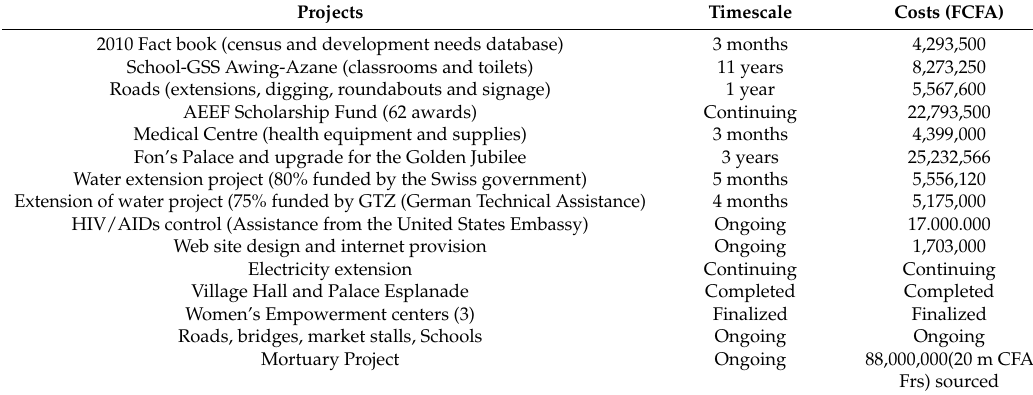
Table 1. Balance Sheet of Ndong Awing Cultural and Development Association (NACDA) Projects, Timescale, and Projected